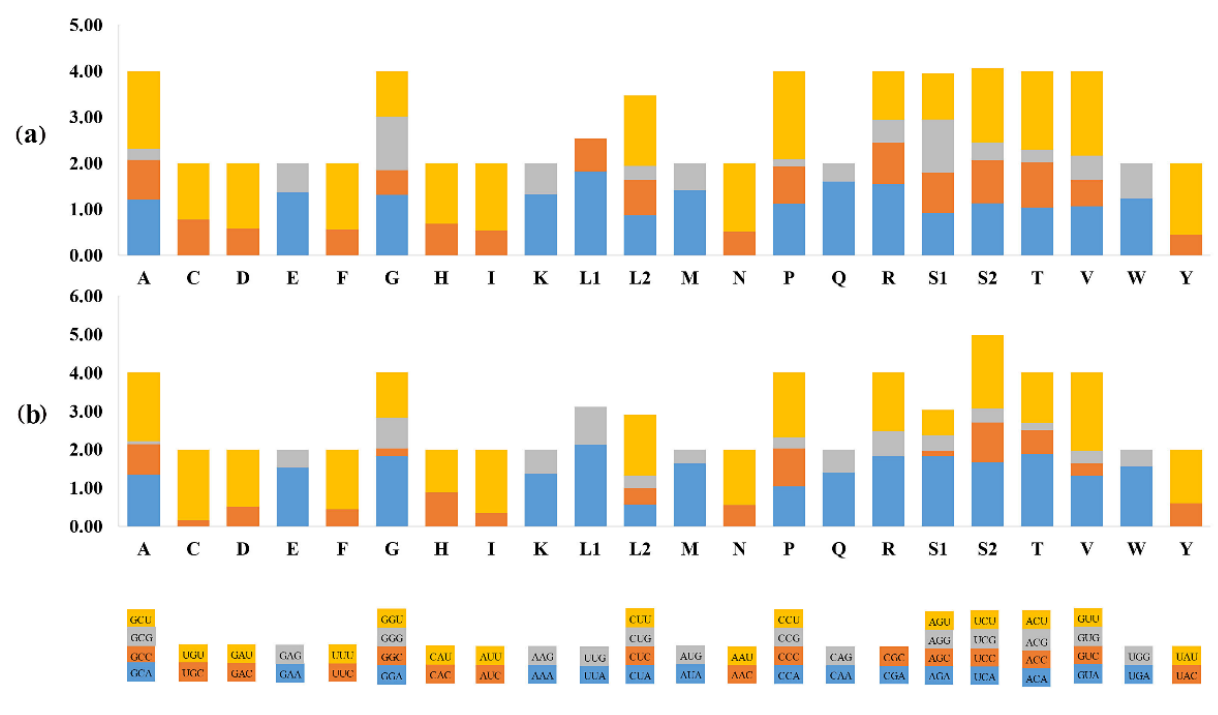
Figure 2. The relative synonymous codon usage (RSCU) in two newly sequenced species: ( a ) P. cas- taneus ; ( b ) P. laterotarsus . The X -axis indicates the codons, and the Y -axis indicates the RSCU values.